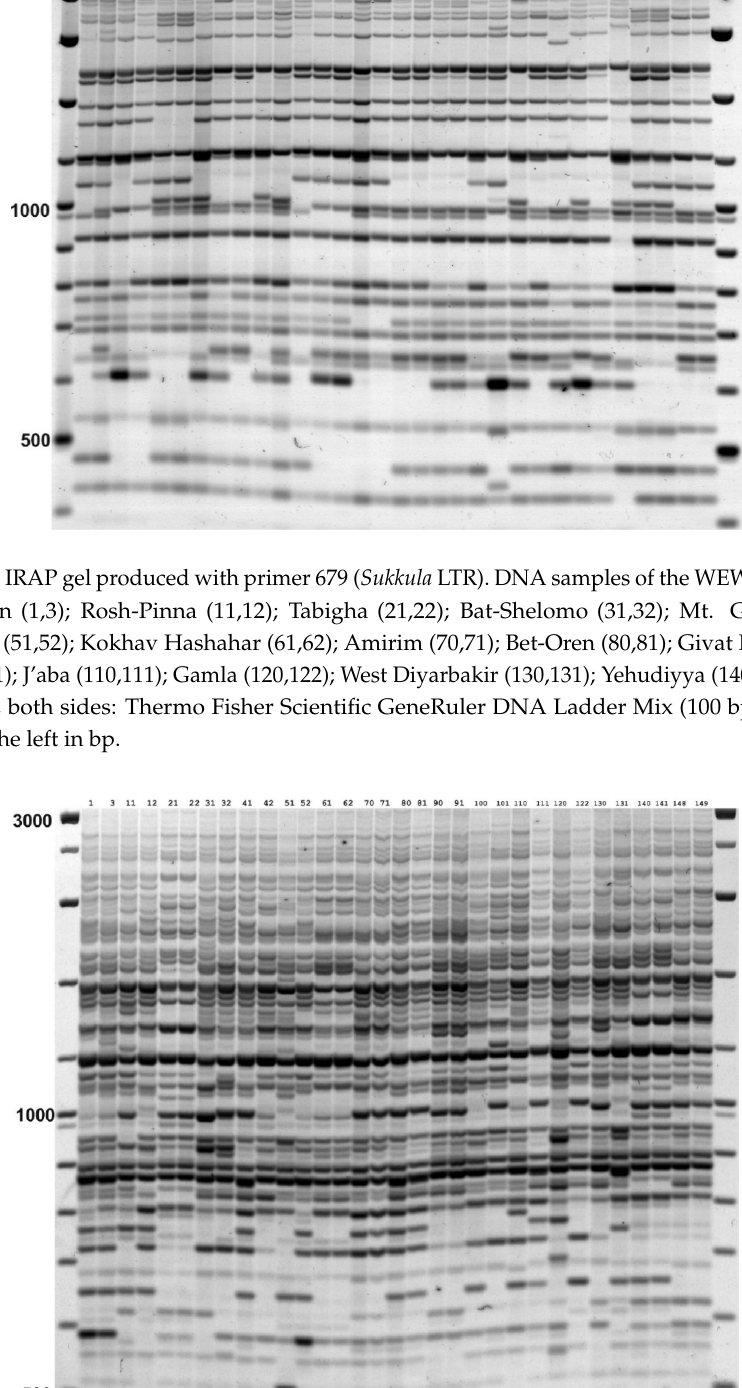
Figure 3. An IRAP gel produced with primer 2108 ( Wilma ‐ Bagy 2 LTR). DNA samples of the WEW